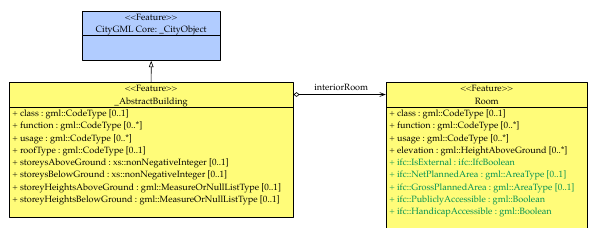
Figure 5. The UML representation of the sample ADE (additions in green) to conserve relevant information from the IFC source supporting potential use cases such as indoor navigation.